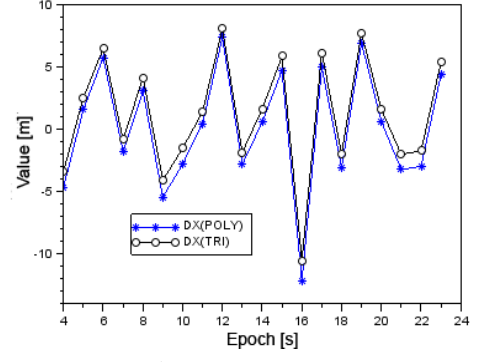
Figure 2. The values of DX parameter based on polynomial and trigonometric method.